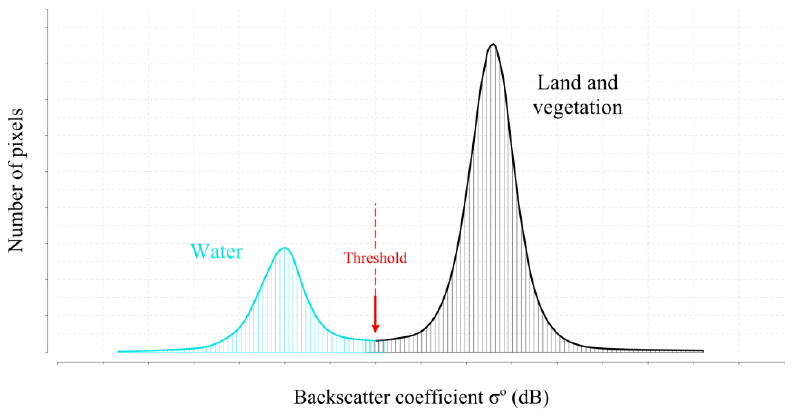
Figure 6. Example of a histogram of SAR backscatter intensity. Based on the SAR backscatter coefficient histograms of each image, the water segmentation threshold was adjusted via graphical interpretation, seeking to minimize noise and maximize water area (see an example in Figure 7).